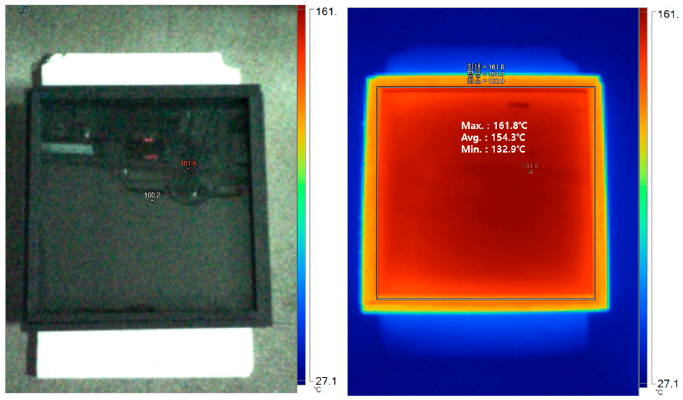
Figure 10. Experimental results for the heating system with a susceptor at a target temperature of 200 °C and a heating rate of 8 °C/min. An image of the glass ( left ) and the temperature distribution ( right ).